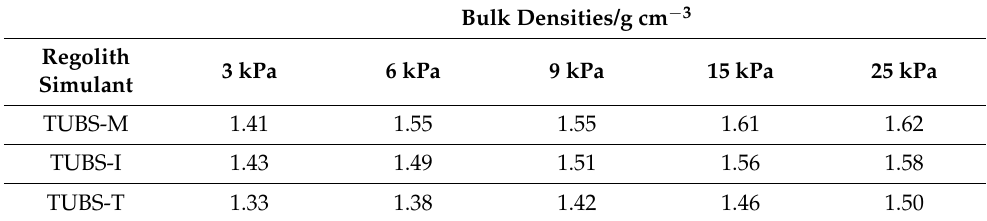
Table A4. Bulk densities of TUBS-M, TUBS-T, and TUBS-I at different shear